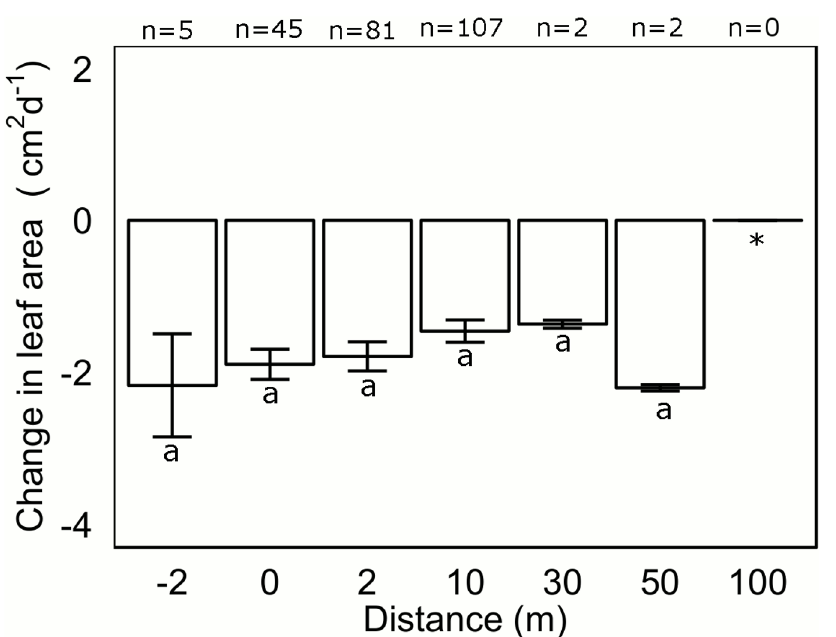
Fig 3. Mean change in leaf area (cm 2 d -1 ) of Posidonia australis transplants (June 2012) after grazing events when planted within a P . australis seagrass meadow then at increasing distances from the P . australis meadow edge. Columns represent means ± 1 SE. * not included in analysis because no grazing event was recorded at 100m.